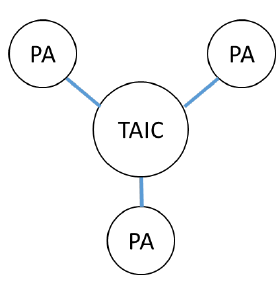
Figure 2. Final structure of the crosslinked PA and TAIC.